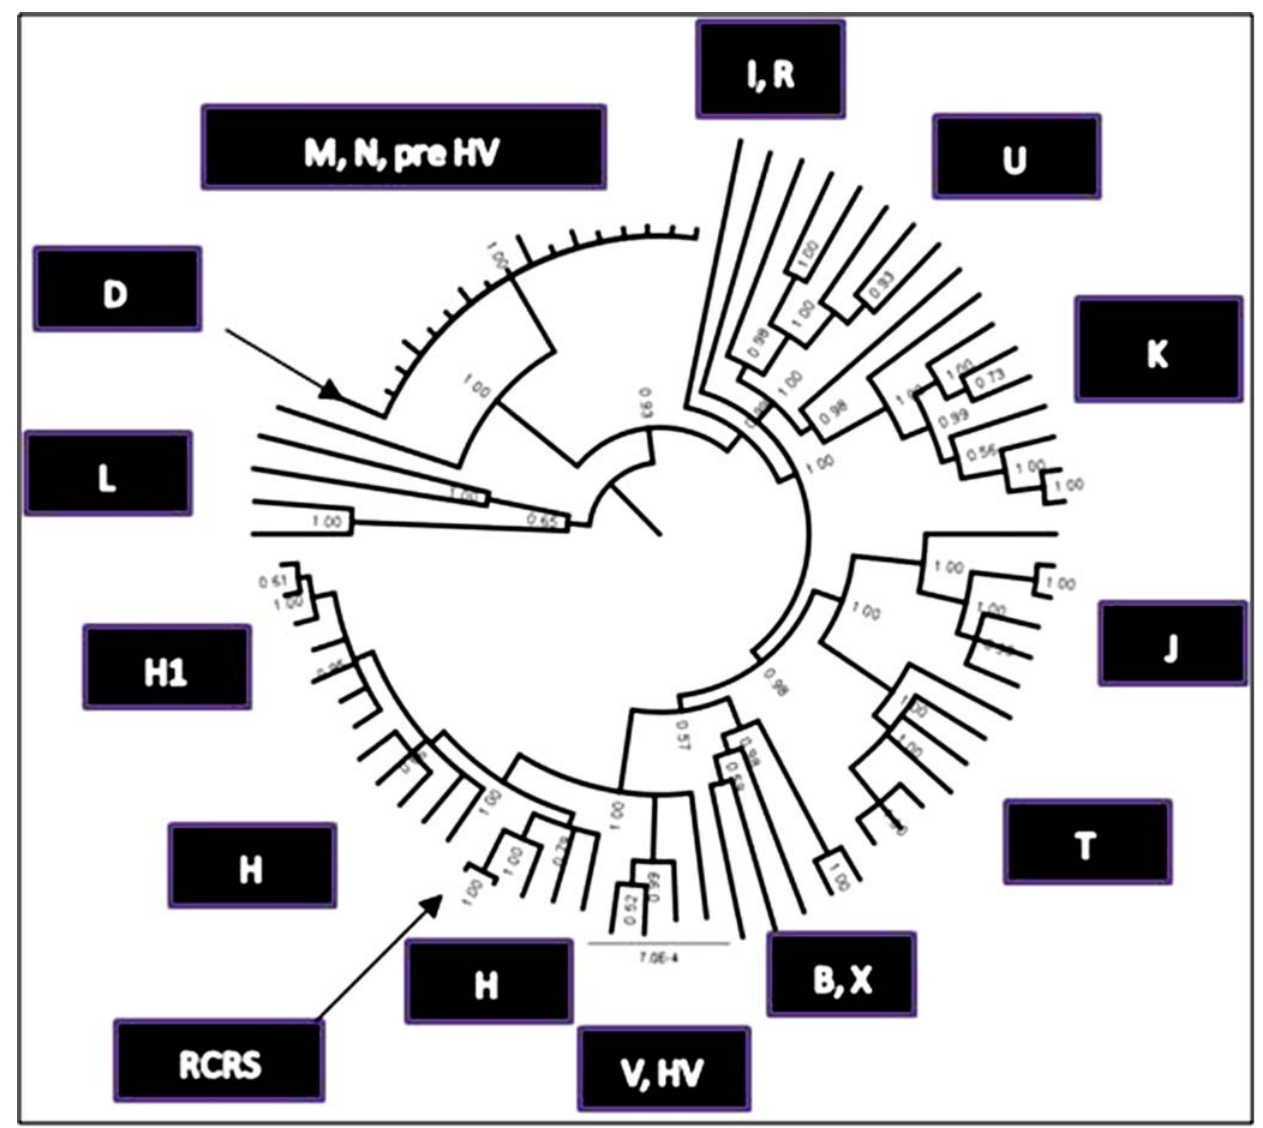
Figure 1. Phylogenetic tree of human mtDNA coding sequence variants demonstrating regional association of haplogroups using mtDNA sequence from DLPFC. Haplogroups, groups of related haplotypes, are derived from a founding haplotype, harboring characteristic mtDNA sequence polymorphisms. Each haplogroup is designated by a letter in this tree, the RCRS is the reference sequence; the ticks around the perimeter of the circle represent the individual mtDNA sequences from DLPFC. The faint numbers represent the probability of support for the branches which was 0.9–1.The mtDNA haplogroups have proven to be highly geographically associated [109]. The haplogroup assignments were calculated at MITOMASTER (http://mammag.web.uci.edu/twiki/bin/view/Mitomaster/WebHome) using all mtDNA sequence base